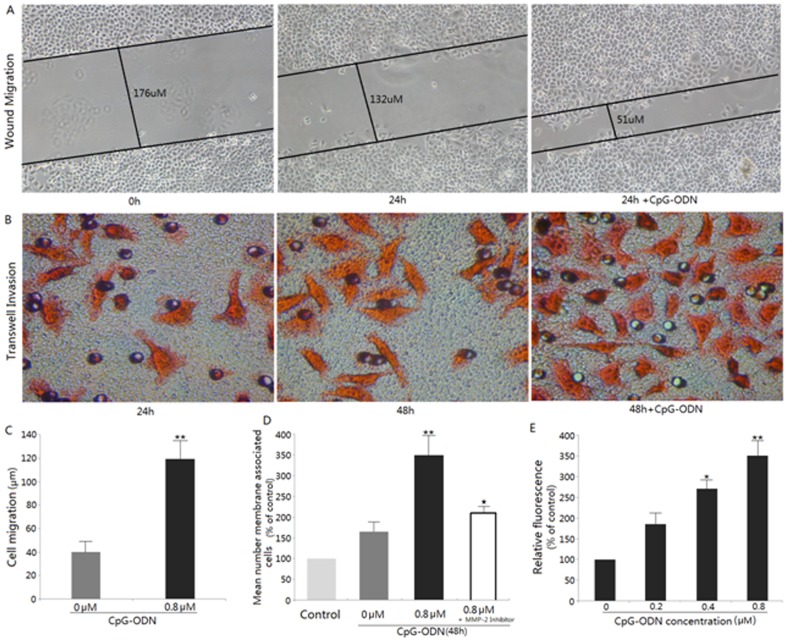
Analysis of migration and invasion of CpG-ODN treated HB cells.(A) Evaluation of cell migration by scratch wound healing assay: Cells were allowed to migrate with and without 0.8 μM CpG-ODN. Cell migration into the wound surface was then monitored by microscopy after 24 h of the CpG-ODN treatment and reported as the width of remaining wounded area relative to the initial wound area. (B)Evaluation of cell invasion by transwell assay. Representative photomicrographs of the membrane-associated cells (jacinth part) were assayed by Eosin staining (×400). (C)Graphical representation of scratch wound assay. The average distance of cell invasion was significantly greater in the CpG-ODN treated sample. **P<0.01. (D)Semi-quantitative analysis of the stimulate-invasion effects of CpG-ODN on HB cells. “% of control” denotes the mean number of the cells expressed as a proportion of the control group and the average of three independent experiments ± S.D. **p<0.01, compared with the lane 2; ★p<0.05, compared with the lane 3. (E)Colorimetric analysis of CpG-ODN modulation of HB cell invasiveness with different concentrations (0∼0.8 μM) for 48 h by the CytoSelect cell invasion assay. *p<0.05; **p<0.01, compared with lane 1.